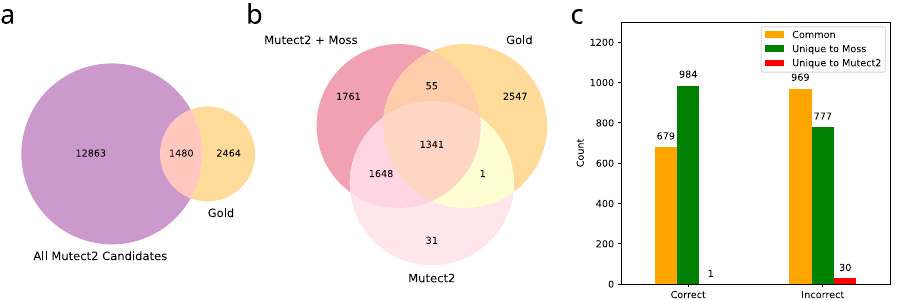
Fig. 4 Moss increases the recall rate in an acute myeloid leukemia (AML) dataset with a manually curated “ gold list “ of SNVs (single-nucleotide variants) 22 . a Venn diagram comparing the candidate set of Mutect2 with the gold list, when run independently in the whole-genome sequencing (WGS) primary tumor and relapse samples. b Venn diagram comparing the SNVs called by Moss and Mutect2 with the gold list. c Number of SNVs discovered by Mutect2 and Moss designated as “ correct ” or “ incorrect ” based on examining the VAFs in the custom targeted capture data. Color indicates whether the variant is common to Mutect2 and Moss (yellow), or unique to Moss (green) or Mutect2